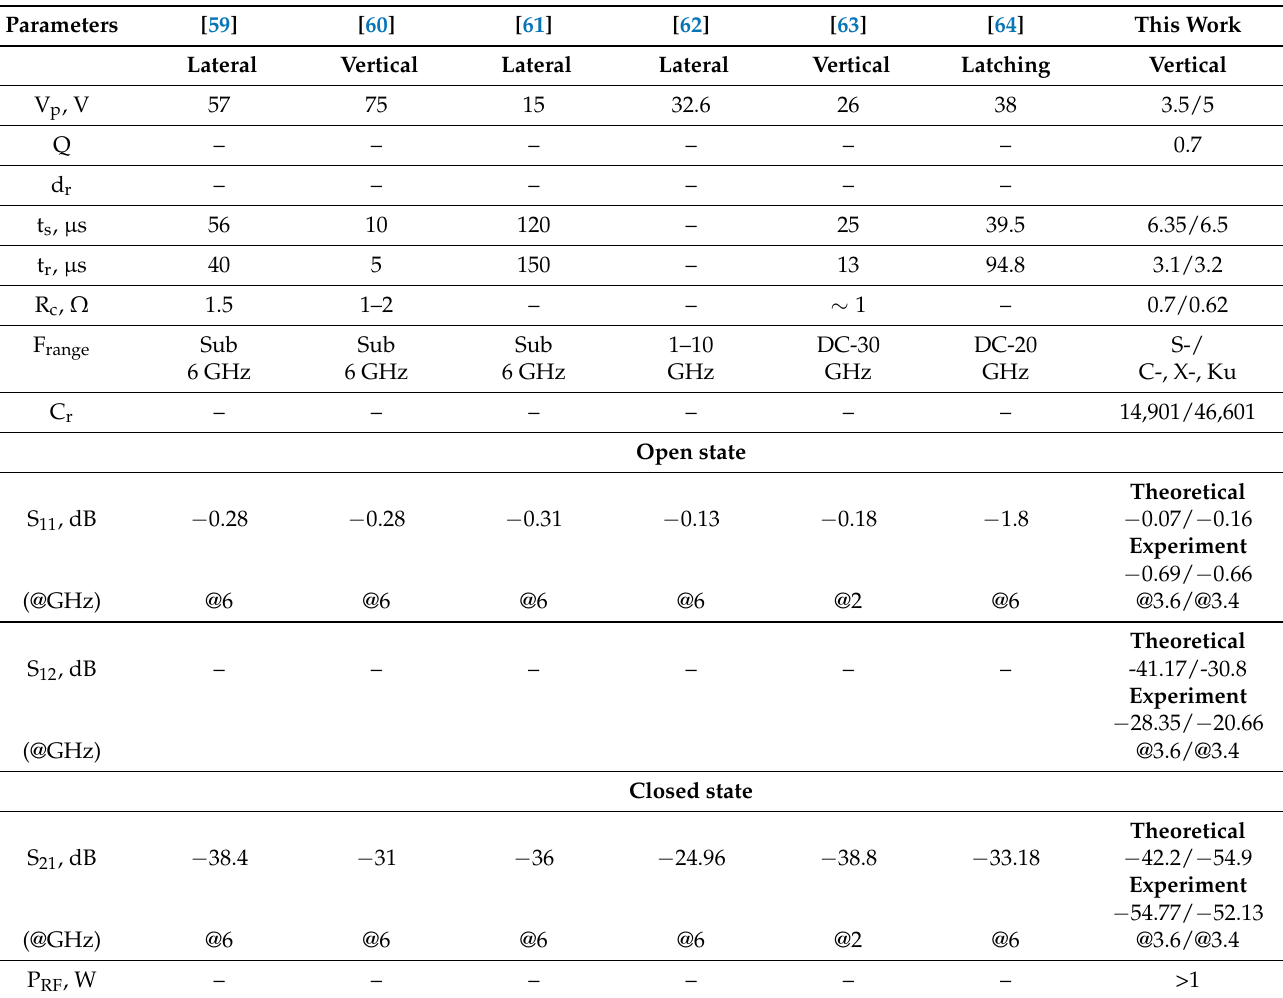
Table 9. Comparison of the results